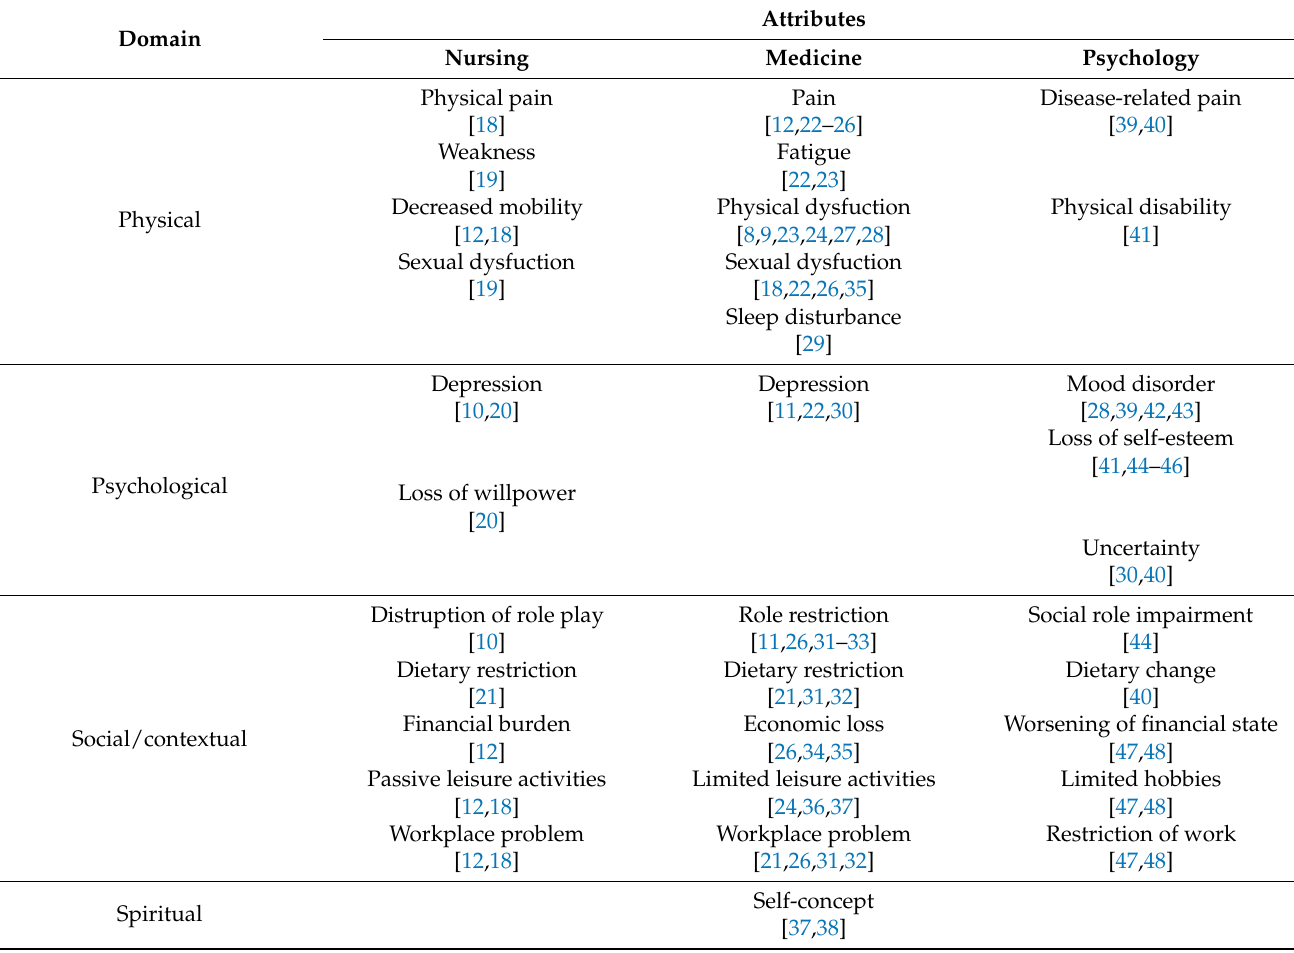
Table 1. Attribute of Illness Intrusiveness in Chronic Disease according to Academic